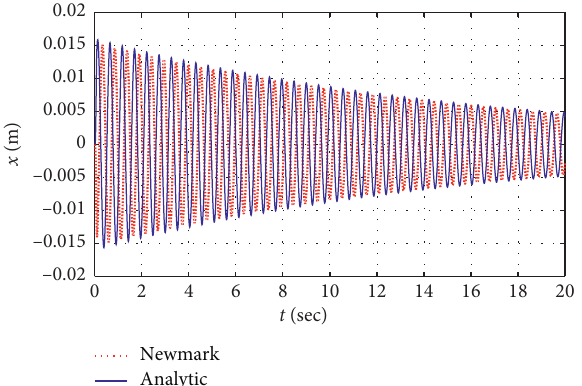
Figure 8: Response of the beam with the Newmark and analytical methods for ξ � 0 . 4% and ω � 60rad/s.